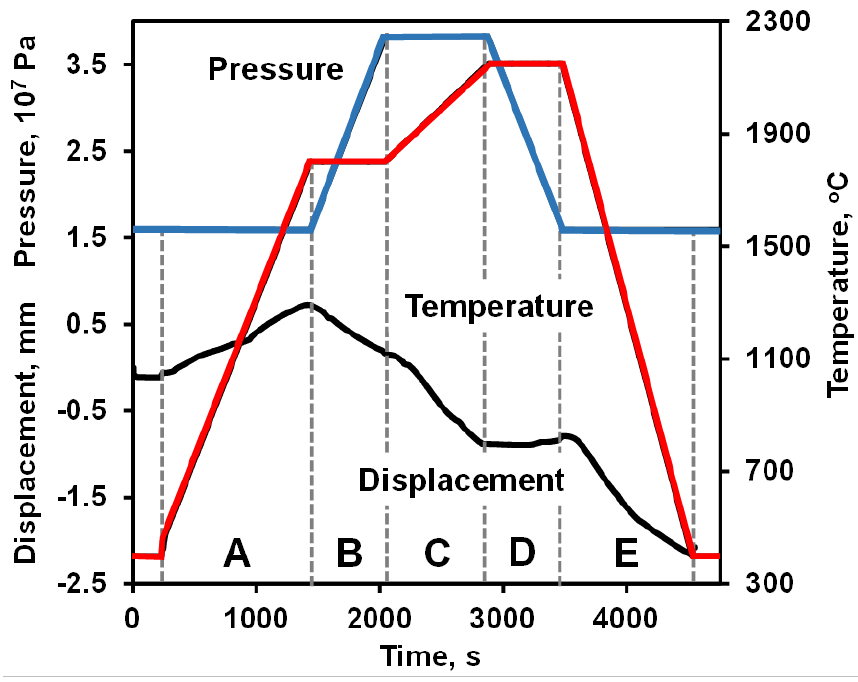
Figure 1. Pressure, temperature and shrinkage of B 4 C densified by SPS.